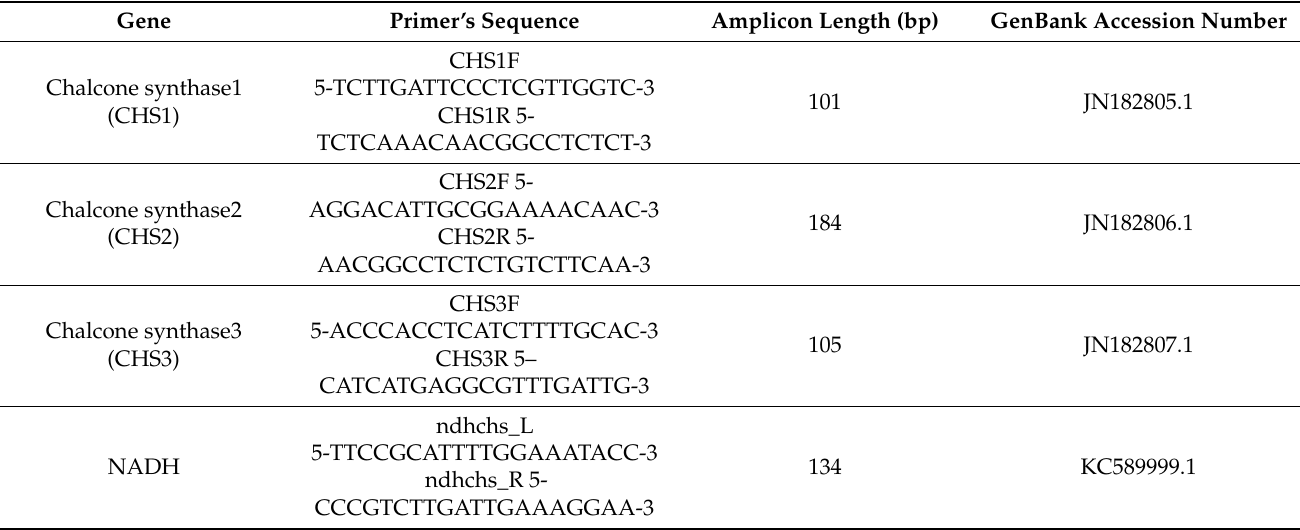
Table 3. Sequences of forward and reverse primers for real-time